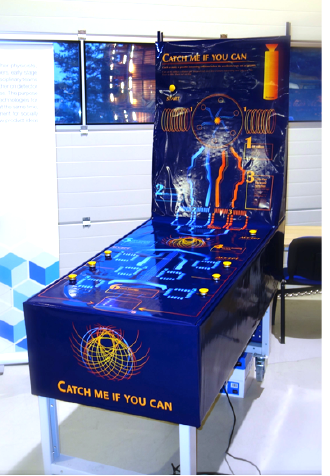
Fig. 2. The ruggedized exhibit on the CMS visitors’ path since June